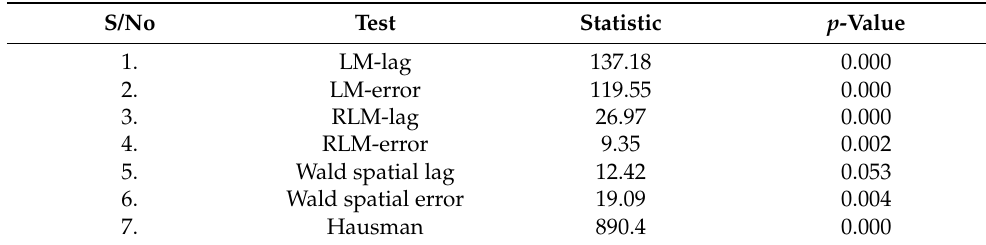
Table 7. Test results of the spatial panel model selection